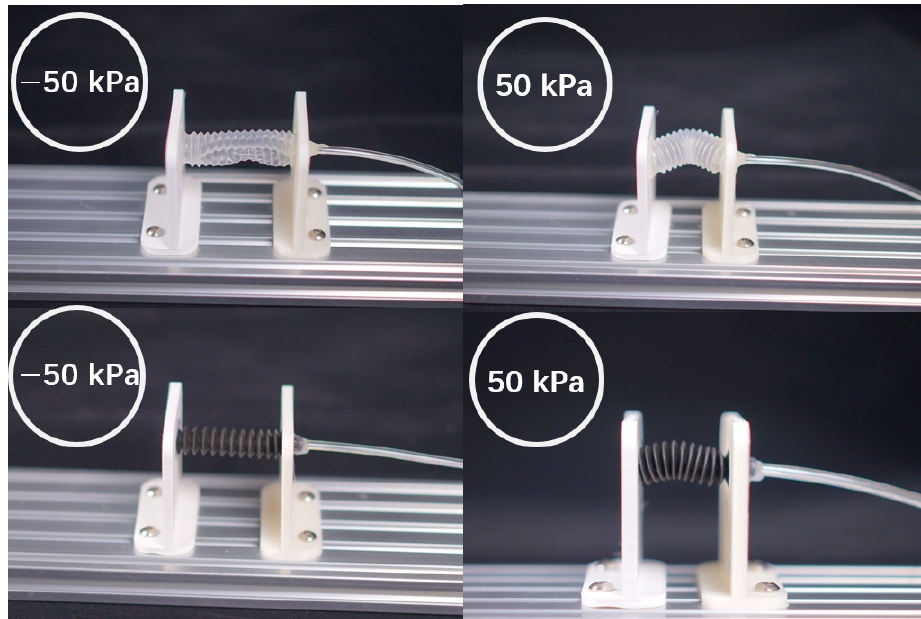
Figure 6. Comparison of EVA circular bellows and TPE GBBA: stretched to the same ratio for structural stability tests with the same deflation or compression ratio.